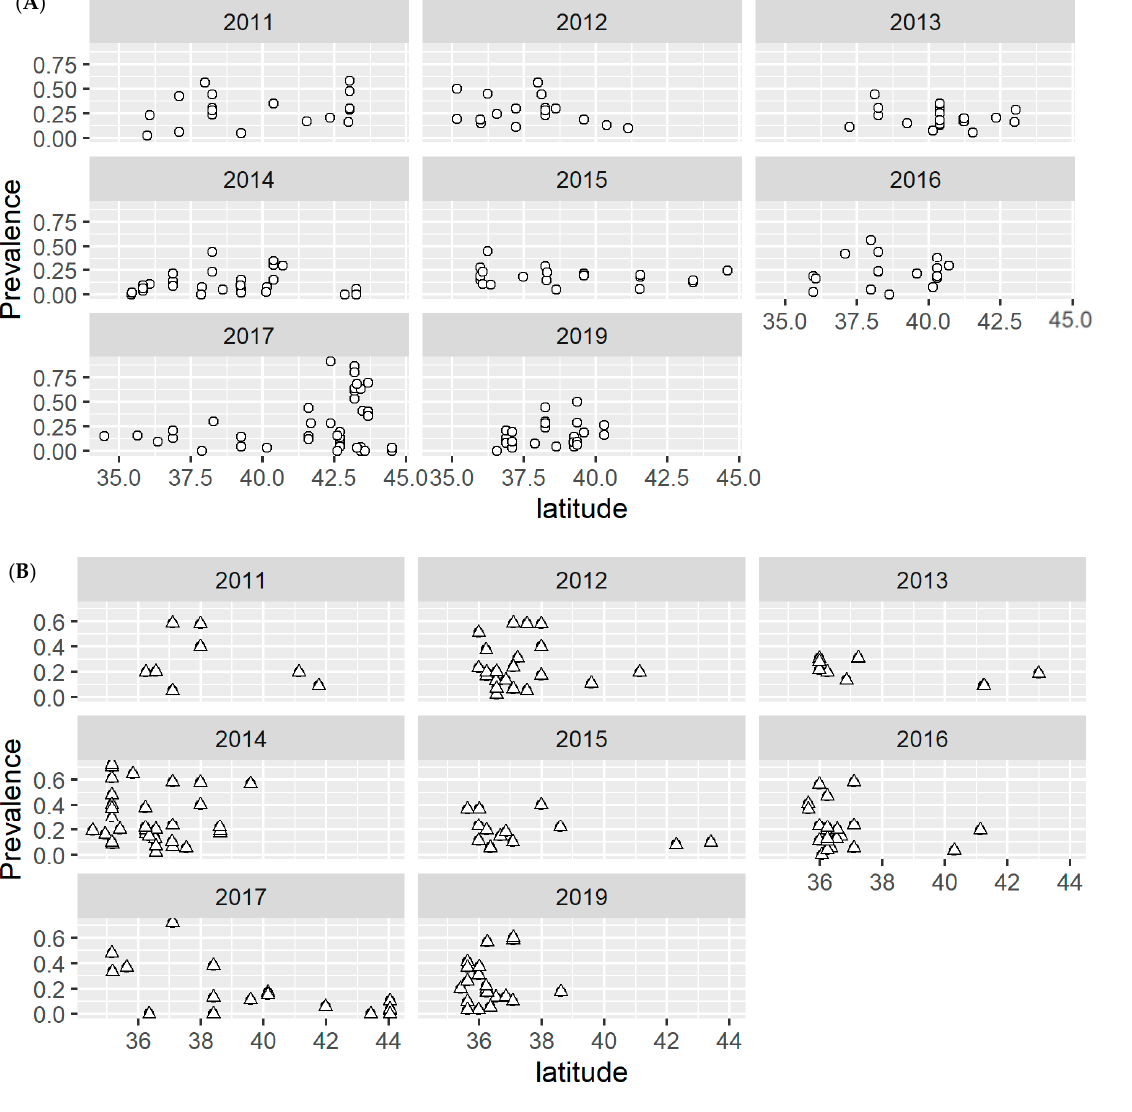
Figure 4. Prevalence by latitude and year for Q. rubra ( A ) and Q. alba ( B ). In Q. rubra , year had a significant effect on prevalence (F = 3.94, df = 7, 178, p = 0.0005) but there was no significant interaction between year and latitude (F = 1.24, df = 7, 178, p